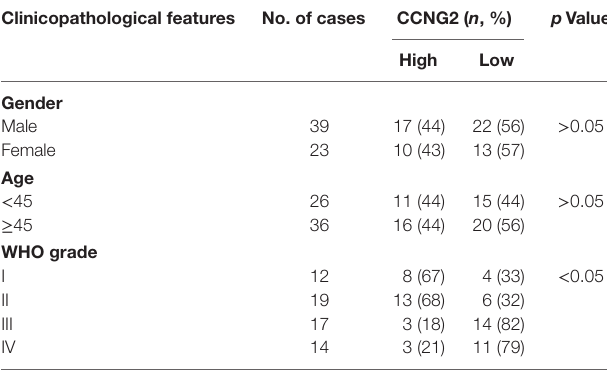
Table 1 | Relationships between CCNG2 expression in human glioma tissues and clinicopathological features. clinicopathological